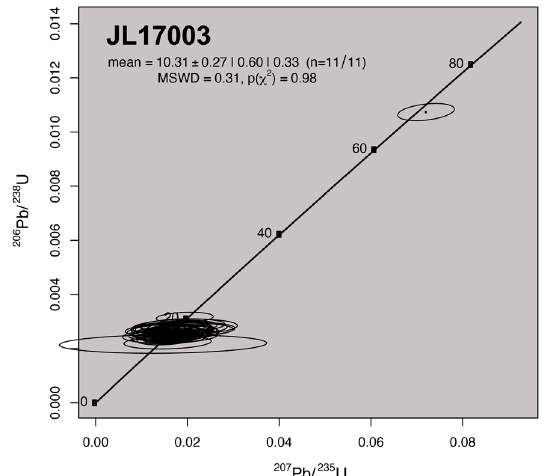
Figure 13. U-Pb LA-ICPMS zircon age of a quartz diorite intruding the Silante Formation (sample JL17003), plotted on a concordia diagram. Errors are given at the 2 ơ level.